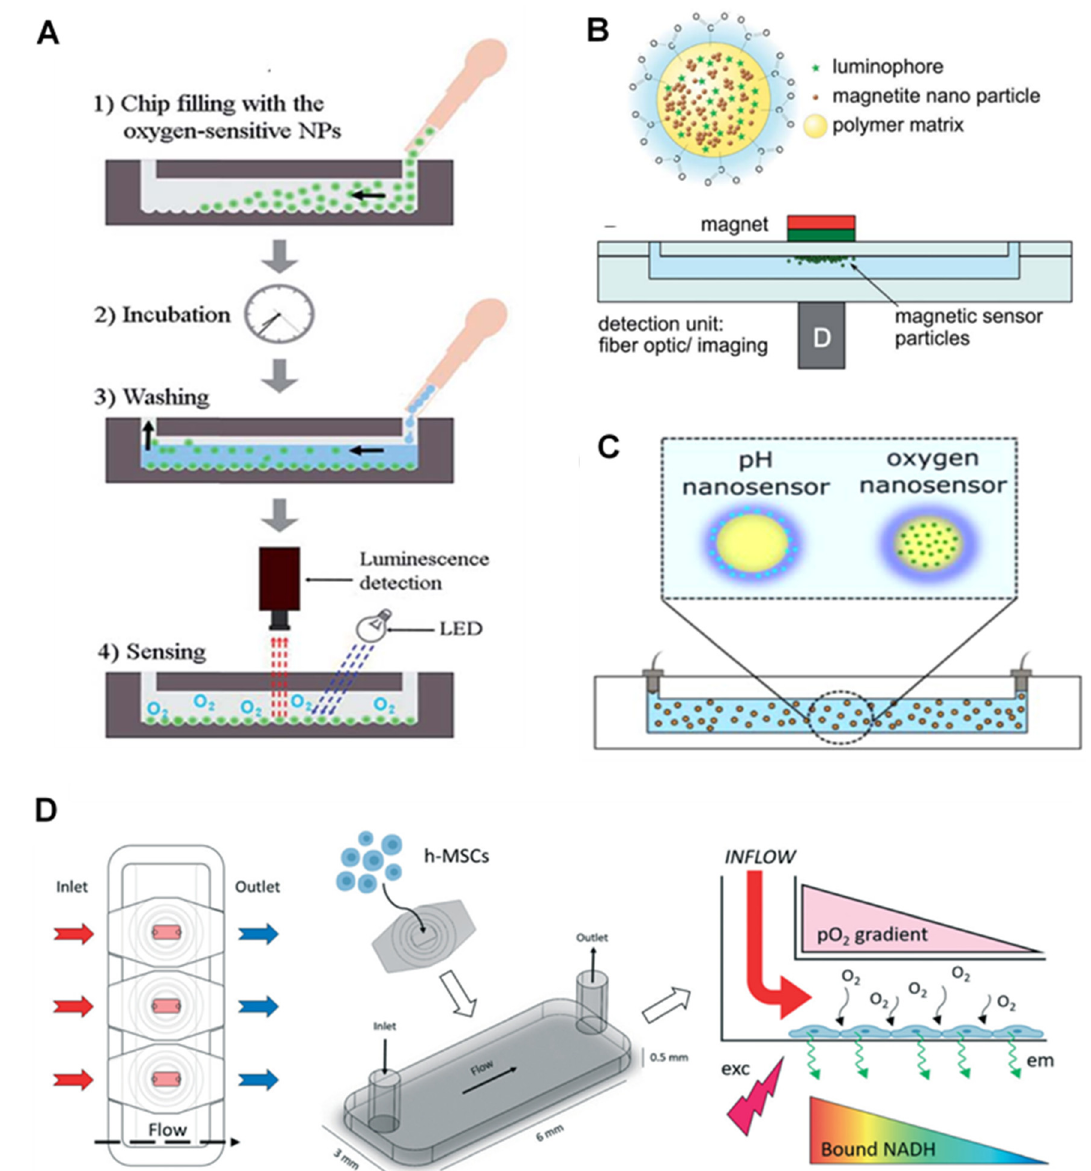
Figure 2. Application of nanoparticles for O 2 sensors in on-chips. ( A ) Nanoparticles are introduced into the channels to attach to the microbeads inside the chip and form an O 2 -sensitive layer. Repro- duced with permission [51] , copyright 2015, The Royal Society of Chemistry. ( B ) Magnetic NPs with luminophore come together in a spot in the chip parallel to where the outside magnet is located. Reproduced with permission [76] , copyright 2014, The Royal Society of Chemistry. ( C ) Sensitive dyes in core-shell NPs for simultaneous detection of O 2 and pH. Reproduced with permission [76] , copyright 2014, The Royal Society of Chemistry. ( D ) Chip-based stem cell culture to monitor O 2 gradient via optical luminescent sensing layers. Reproduced with permission [48] , copyright 2021, The Royal Society of Chemistry.